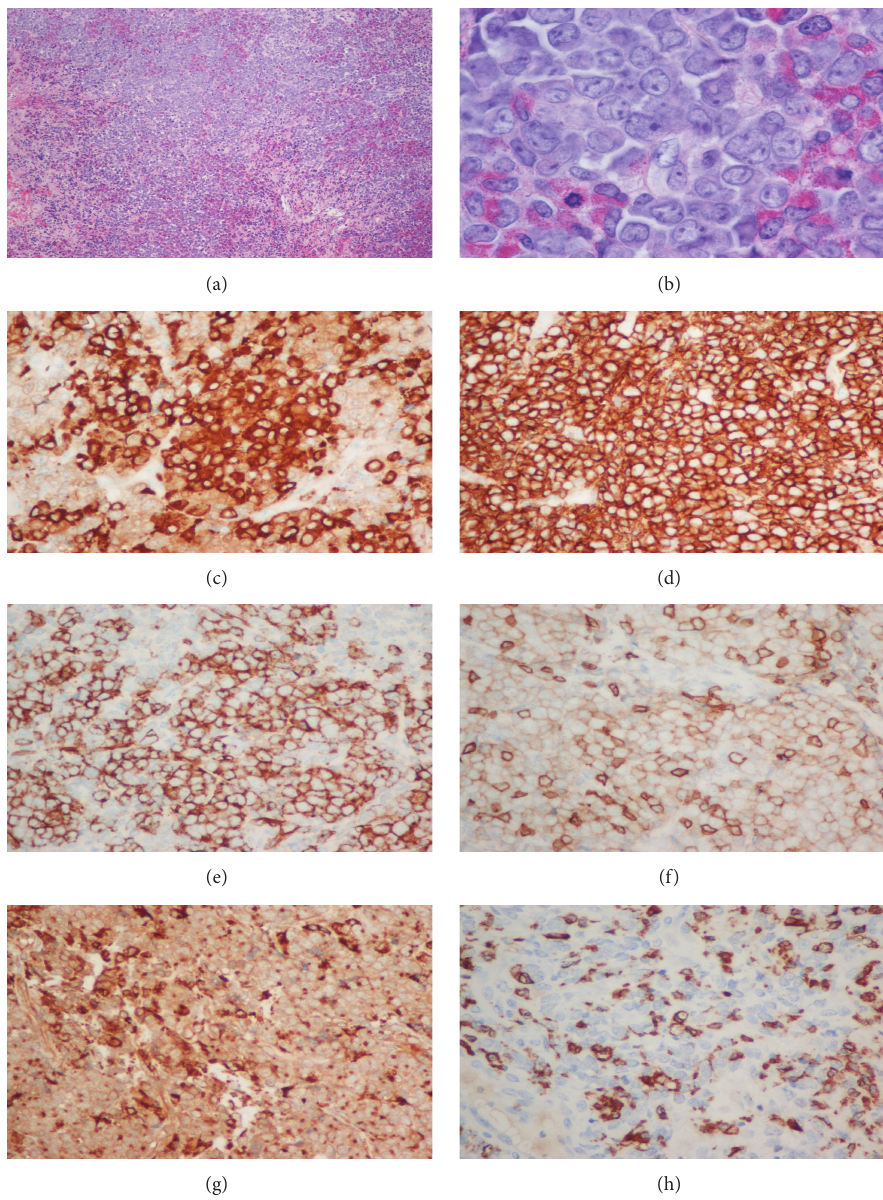
Figure 3: (a) H&E, low power. (b) H&E, high power. (c) Myeloperoxidase focal positivity. (d) CD43 commonly expressed in myeloid sarcoma. (e) CD34 (marker of immaturity). (f) CD117 focal+ (expressed in immature myeloid cells). (g) CD68 weak+ (monocytic/histiocytic markers). (h) CD163 focal+ (monocytic/histiocytic